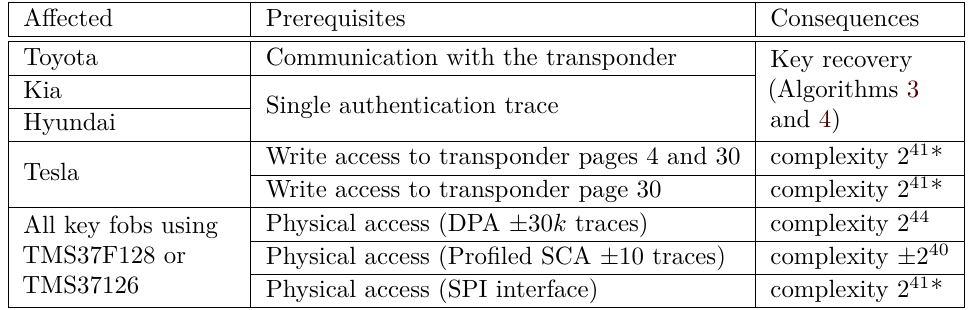
Table 4: Attacks on DST80 transponders described in this paper. In the scenarios marked by an asterisk lookup tables can be employed to speed up the key recovery